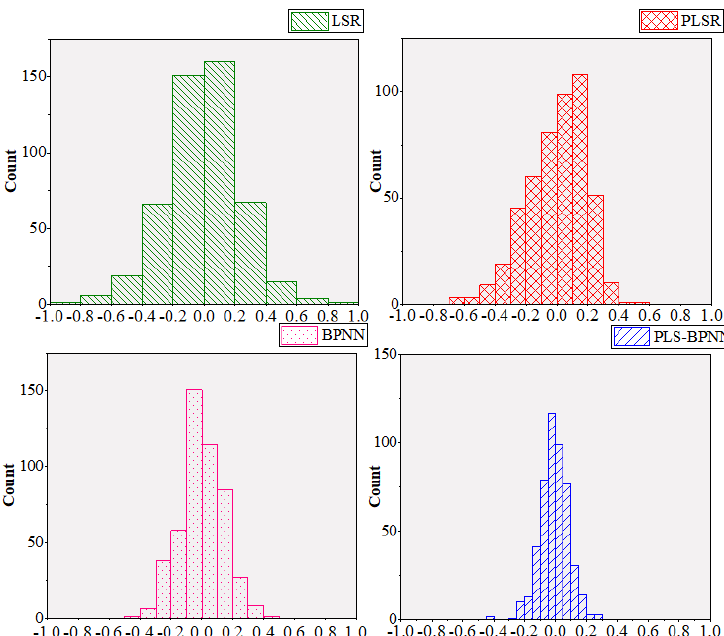
Figure 10. The residual histogram of each model.